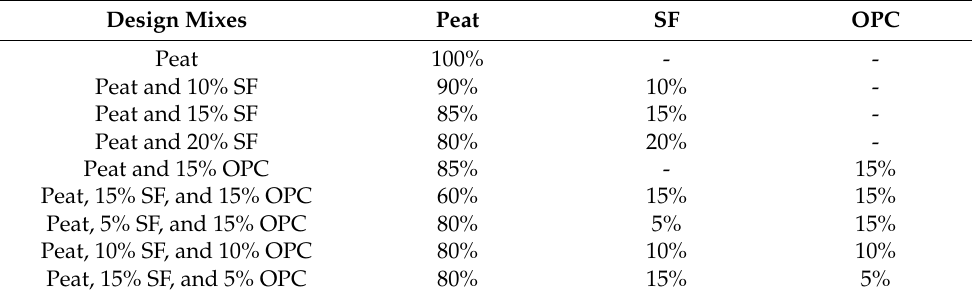
Table 3. Summary of the mix